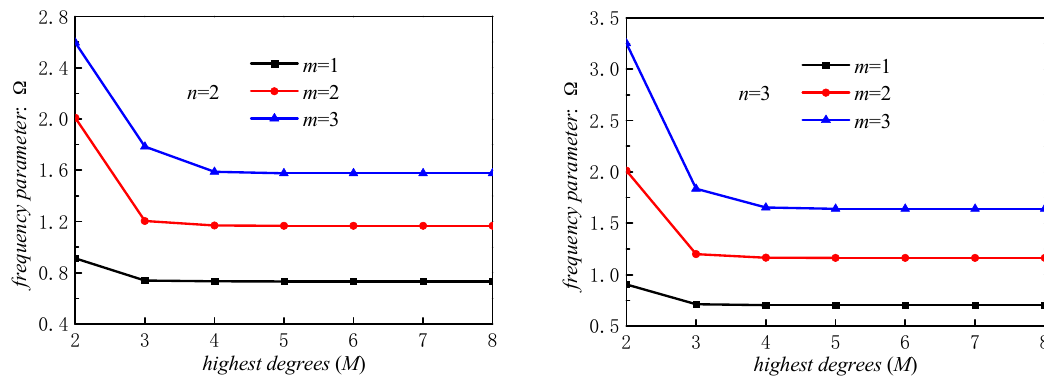
Figure 6. Frequency parameters Ω for various truncation in stepped FG paraboloidal shell.